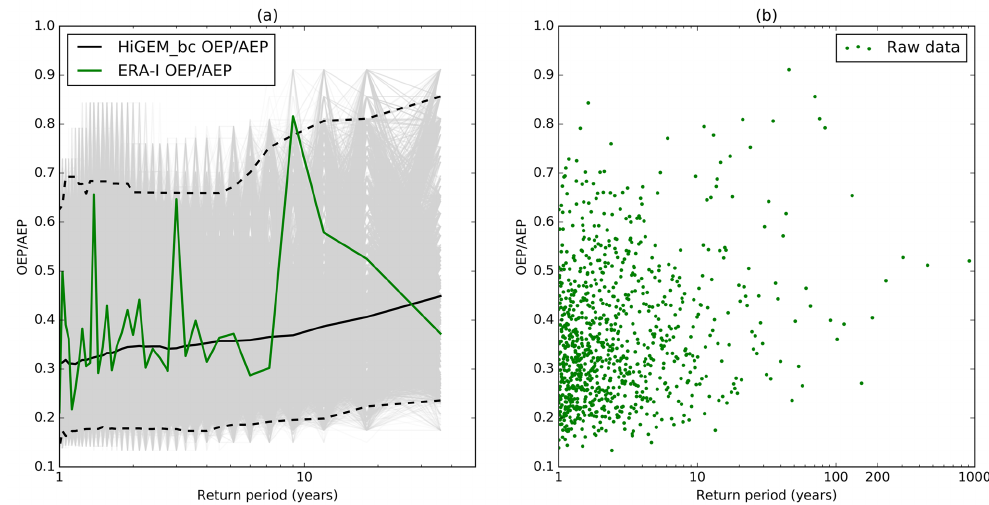
Figure 8. (a) Return periods of OEP/AEP for ERA-Interim (green line). The light grey lines are the 10000 bootstrap samples of the HiGEM_bc OEP/AEP. The black dashed lines are the associated 95% confidence intervals of the HiGEM AEP and the black solid line is the median. (b) Return periods of the OEP/AEP ratio for HiGEM_bc (green